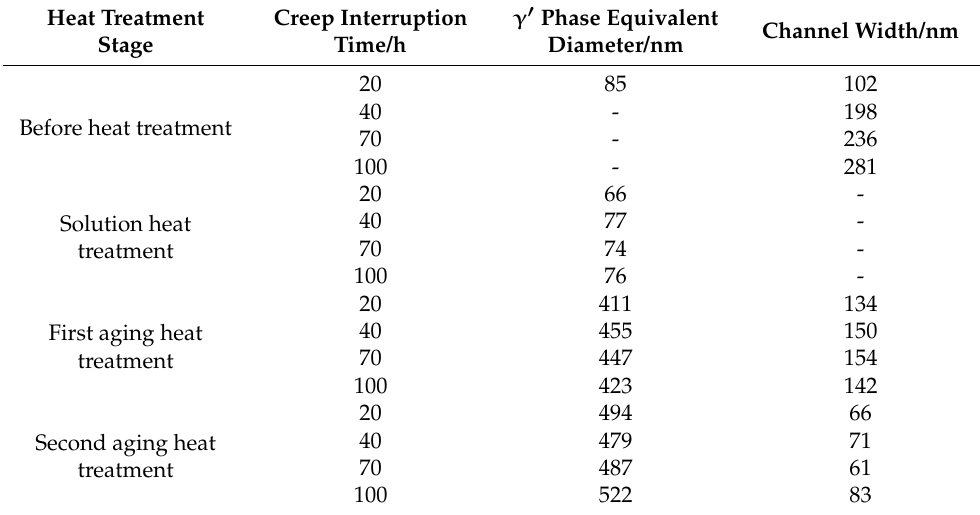
Table 6. Microstructure parameters statistics after different restoration heat treatment